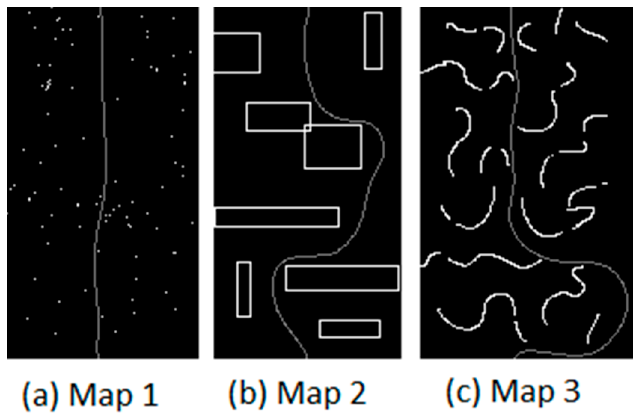
Figure 14. Examples of generated paths for maps presented in Figure 13: ( a ) Path in forest-like map; ( b ) Path in buildings-like map; ( c ) Path in some complex environment.